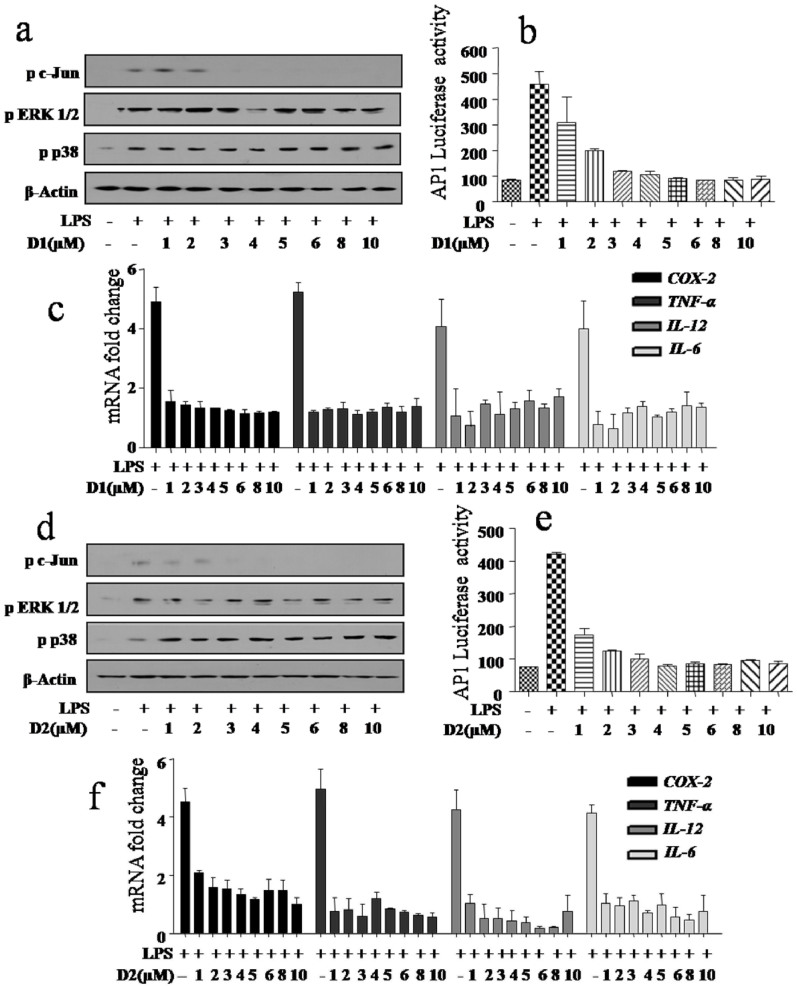
Anthrapyrazolone and its analogues inhibit JNK activity as well as other MAPkinases in concentration dependent manner in mouse macrophages.(a, b) Inhibitory effect of D1 (2-hydroxyethyl) over phosphorylation of c-Jun at lower concentrations analyzed by western blot in mouse macrophages and AP1 luciferase activity (RAW 264.7 macrophages) upon stimulation with LPS for 1 hour and 12 hour respectively. (d, e) Inhibitory effect of D2 (2-hydroxyethyl-7-chloro) over phosphorylation of c-Jun at lower concentrations analyzed by western blot and AP1 luciferase activity upon stimulation with LPS for 1 hour and 12 hour respectively. (c, f) Real Time PCR analysis of COX-2, TNF-α, IL-12 and IL-6 in macrophages upon treatment with D1 and D2 at lower concentrations in presence of LPS (100 ng/ml) respectively. Representative blots of three independent experiments were shown. n = 3, SE ± mean.